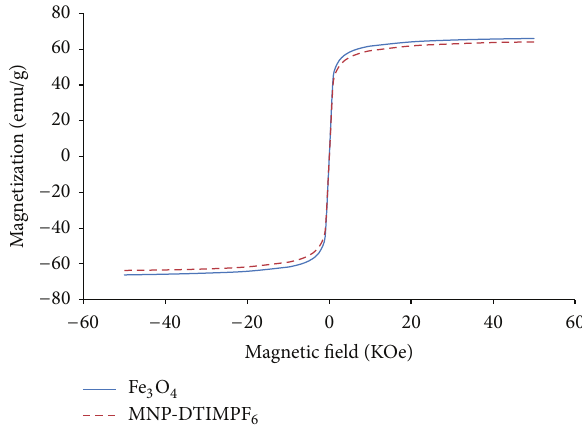
Figure 5: Magnetization versus magnetic field for Fe 3 O 4 and MNP- DTIMPF 6 at 25 ∘ C.